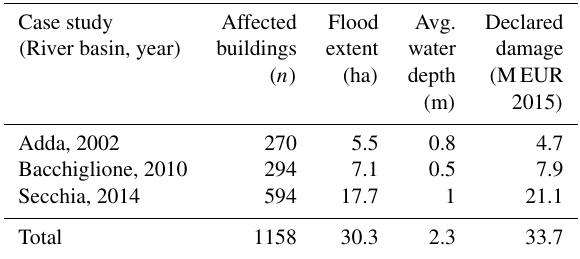
Table 2. Summary of residential buildings affected by the three investigated flood events, according to hydraulic simulations and damage